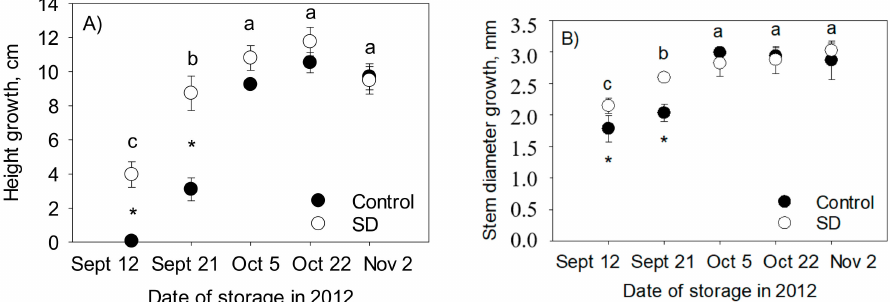
Figure 5. ( A ) Height and ( B ) stem diameter growth of control and short-day (SD)-treated Norway spruce seedlings after the first growing season in the field in 2013 (mean ± SE, n = 6 blocks). The data were subjected to a linear mixed model (MIXED) procedure followed by a simple main e ff ects test with Bonferroni corrections. Letters indicate di ff erences between the storing dates, and asterisks indicate di ff erences between the treatments within each storage date ( p < 0.05).